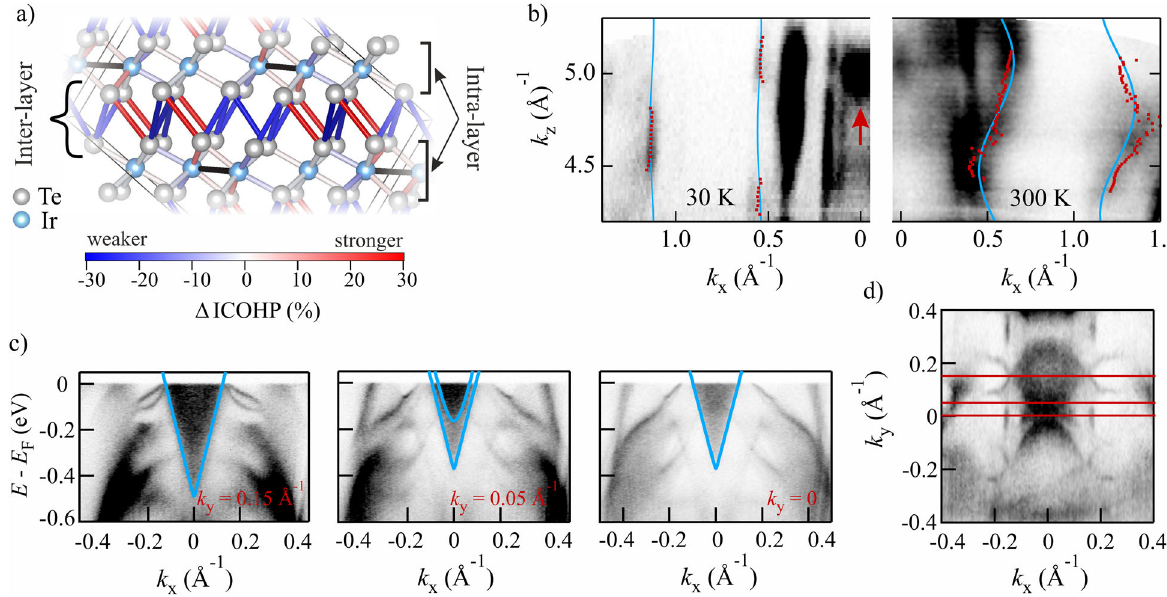
Fig. 4 Observation of reduced interlayer coupling and Lifshitz transition in the Dirac dispersions. a Calculated relative bond strengths in the 6 × 1 phase highlighting signi fi cant weakening of the interlayer bonds. Bond strength changes are given with reference to the integrated COHP in the high-temperature phase. The majority of interlayer bonds are strongly weakened (blue) in the 6 × 1 phase. All bond strengths are tabulated in Supplementary Table S1. b Out- of-plane ( k z ) ARPES dispersions at k y = 0 and E F for strained low-temperature (left) and unstrained high-temperature phases (right) (40 eV < h ν < 100 eV). The k x direction is along the Ir-dimer chains, as in Fig. 1. Red markers show extracted contours obtained via fi tting. Overlaid blue solid lines represent the resulting tight-binding dispersions. The observed narrowing of the warping along k z in the low-temperature 6 × 1 phase implies a signi fi cant reduction of interlayer hopping, providing con fi rmation of the enhanced layer decoupling found in the calculation in ( a ). The red arrow highlights the dispersive bulk- Dirac states (see also supplementary Fig. S6). c ARPES spectrum ( h ν = 20 eV, T = 30 K) at k y = 0.15, 0.05, and 0 Å − 1 revealing overlapping bulk-Dirac states. Overlaid solid blue lines are hyperbolic dispersions matched to the spectral weight. Additional spectra are presented in Supplementary Fig. 7. d Fermi surface ( h ν = 20 eV, T = 30 K) h ighlighting the in-plane structure of the Dirac and surface states at the A-point. Red lines mark the positions of the cuts presented in ( c